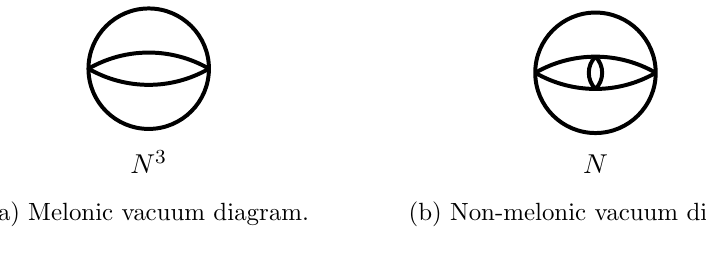
Figure 3. Example: Melonic and non-melonic vacuum diagrams.